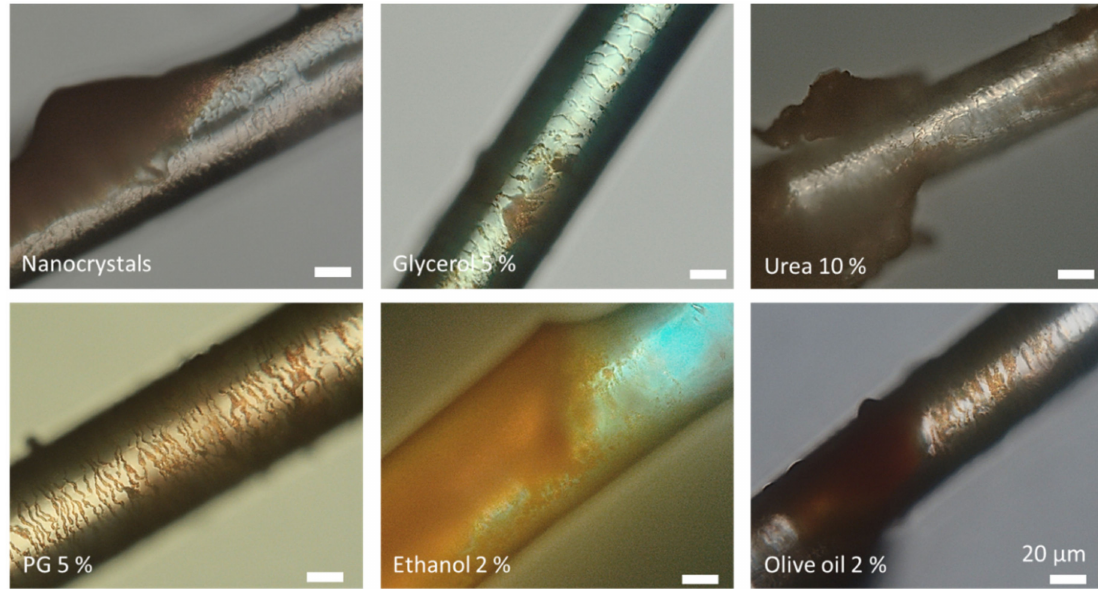
Figure12. Microscopicimagesofhairsremovedfromporcineearstreatedwithnanosuspensionswithout and with excipients after 6 h of incubation (digital zoom of images taken at 400-fold